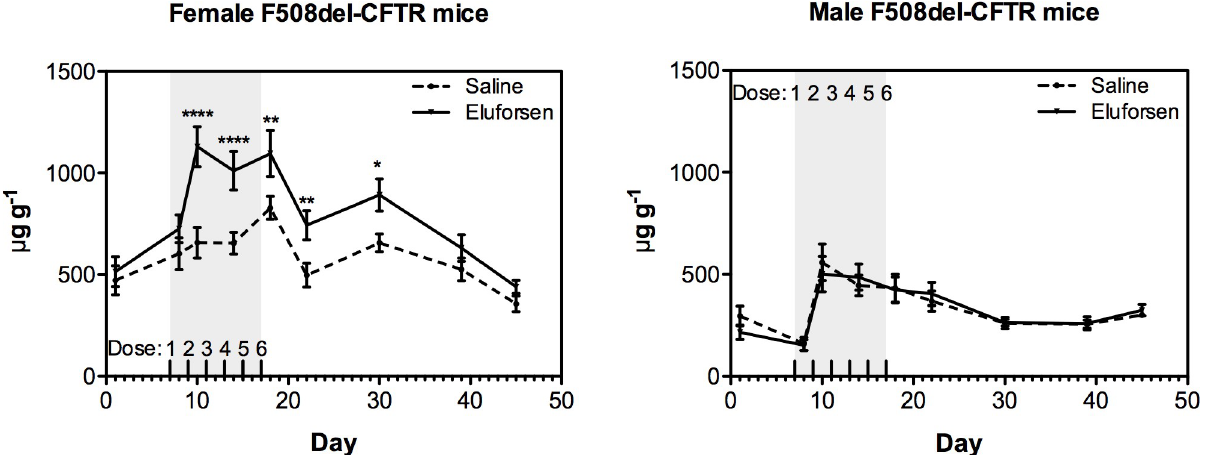
Fig 4. Eluforsen restores CFTR-mediated saliva secretion in female F508del-CFTR mice. CFTR-mediated saliva secretion in eluforsen-treated F508del-CFTR mice before treatment (at day 1) and 24 hours after one (day 8), two (day 10), four (day 14), and six (days 18, 22, 30, 39, 45) OT administrations of saline or eluforsen (10 mg/kg), corrected for body weight ( μ g saliva/g body weight). The symbols and error bars indicate the mean and SEM. The solid line represents the mean CFTR-mediated saliva secretion corrected for body weight in eluforsen-treated (female n = 9; male n = 10) mice and the dashed line represents the saline-treated (female n = 9; male n = 8) mice. Two to six OT administrations of eluforsen significantly improve CFTR-mediated salivary secretion in female F508del-CFTR mice compared with saline-treated controls. CFTR-mediated saliva secretion gradually returned to pre-treatment levels at day 39 (22 days after the sixth dose), confirming washout of eluforsen. Treatment groups were compared using ANCOVA (general linear model), using the effect of baseline (pre-treatment measurement) and repeated measures as covariates. ���� p < 0.0001, �� p < 0.01, � p <